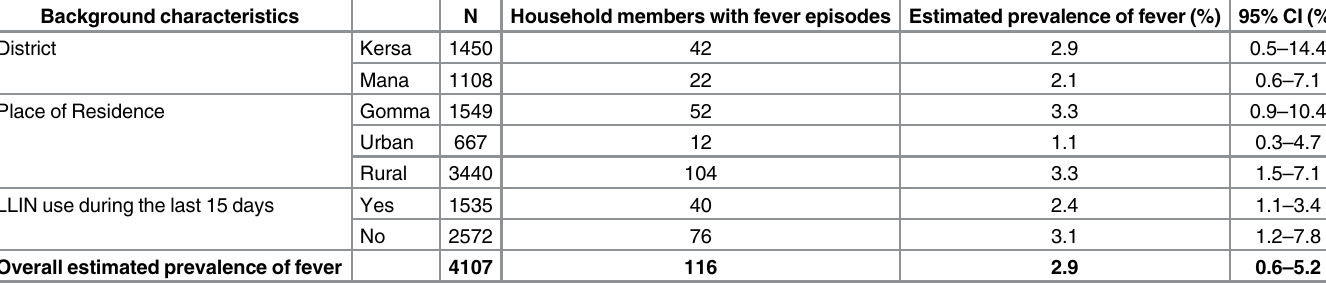
Table 2. Reported prevalence of fever two weeks prior to the survey, Jimma, Ethiopia (Jan 2014). Background